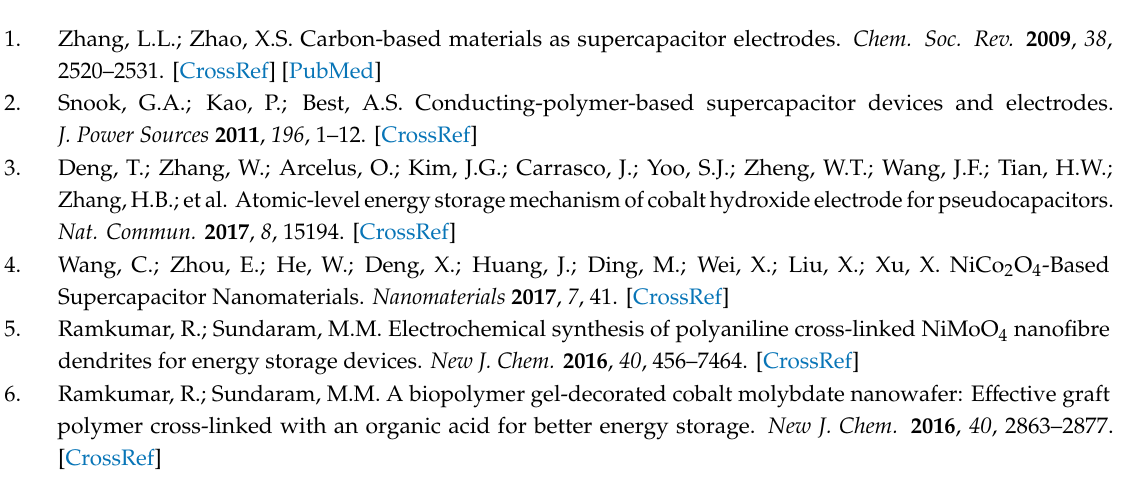
Figure S1: Comparisons of cyclic voltammetry (CV) properties for di ff erent